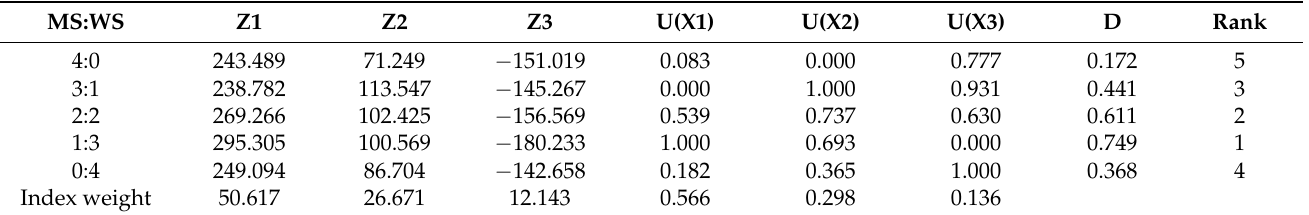
Table 6. The factor scores of comprehensive indexes, index weight, U(Xj) and D value of A. auricula cultivated at different walnut addition